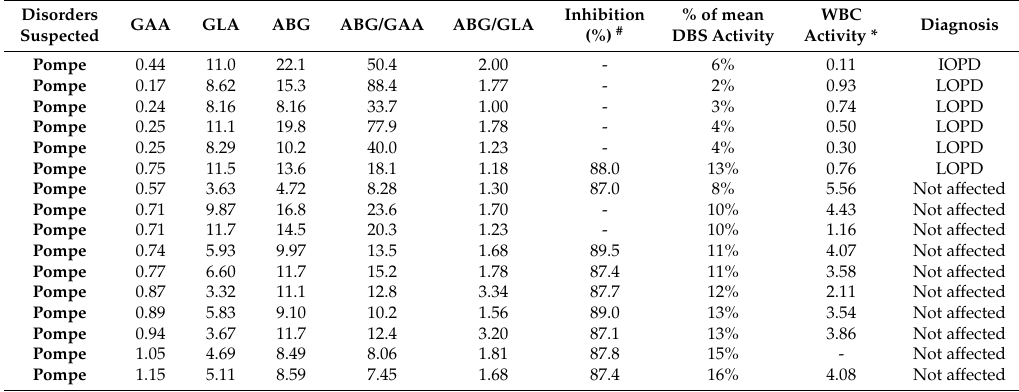
Table 2. NBS and confirmatory testing results of referred infants, and diagnostic determination.